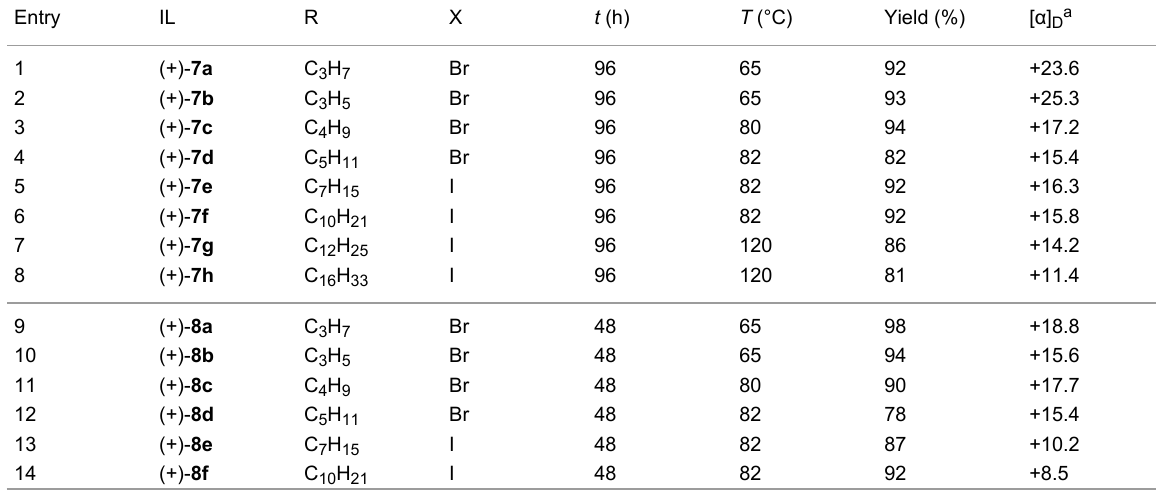
Table 3: Synthesis of chiral imidazolium (+)- 7a – h and triazolium ILs (+)- 8a – f .